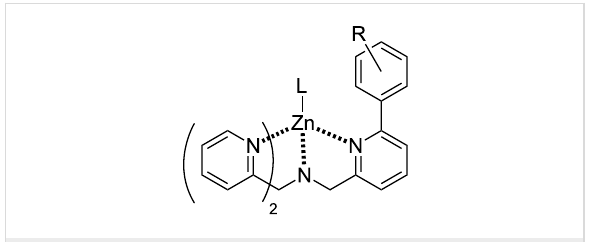
Figure 3: General structure of zinc-TPA